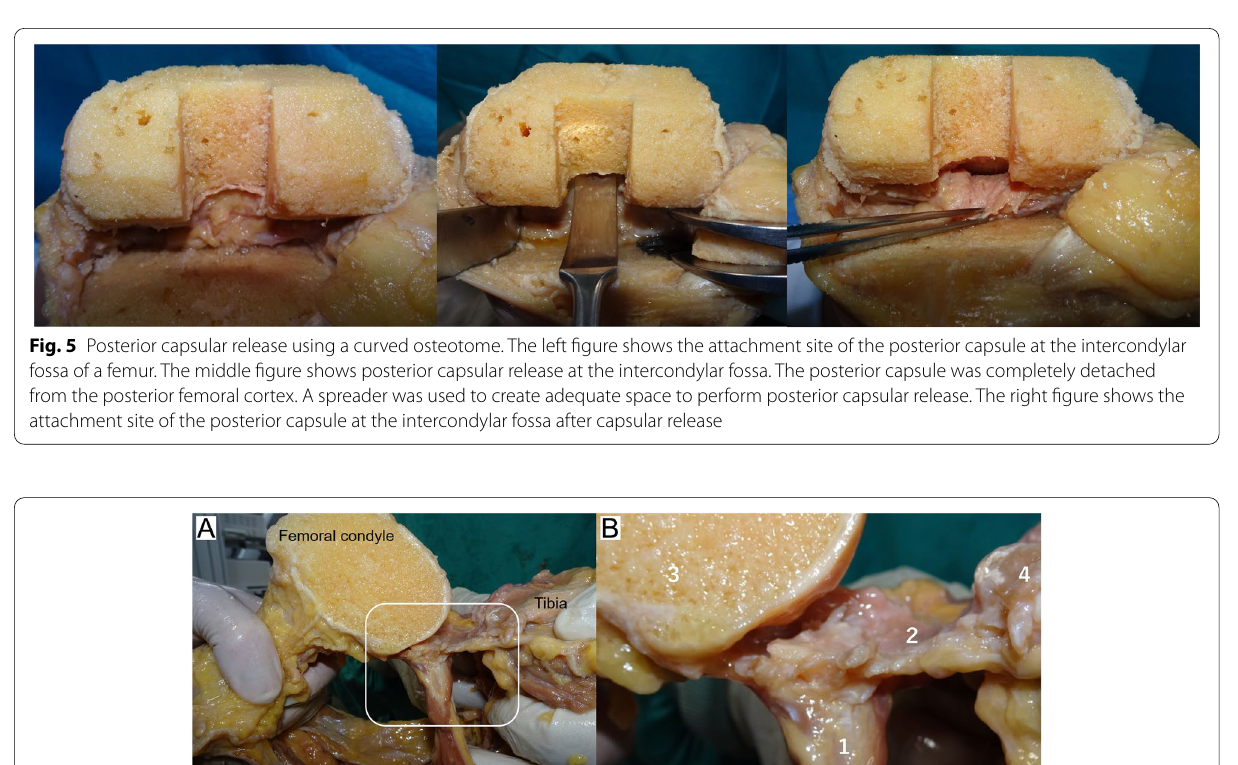
at each condyle. The mean knee extension angles were 15.6° 3.5° with trial component, − ± following capsular release at the intercondylar fossa, 2.4° 2.0° following capsular release at the lateral con- − ± dyle and 1.3° 1.8° after capsular release at the medial ±